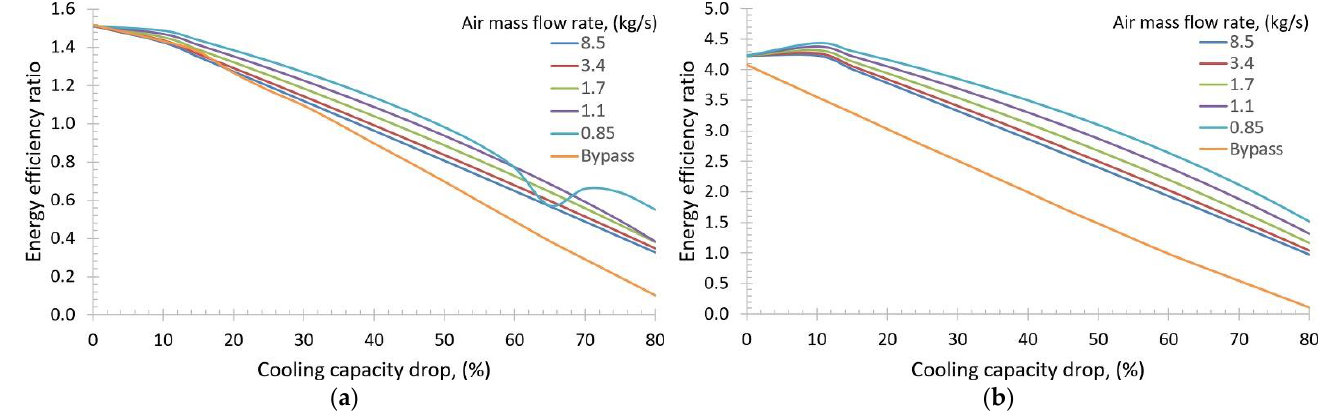
Figure 9. Energy efficiency ratio in the function of cooling capacity drop for different air mass flow rates (additional evap-